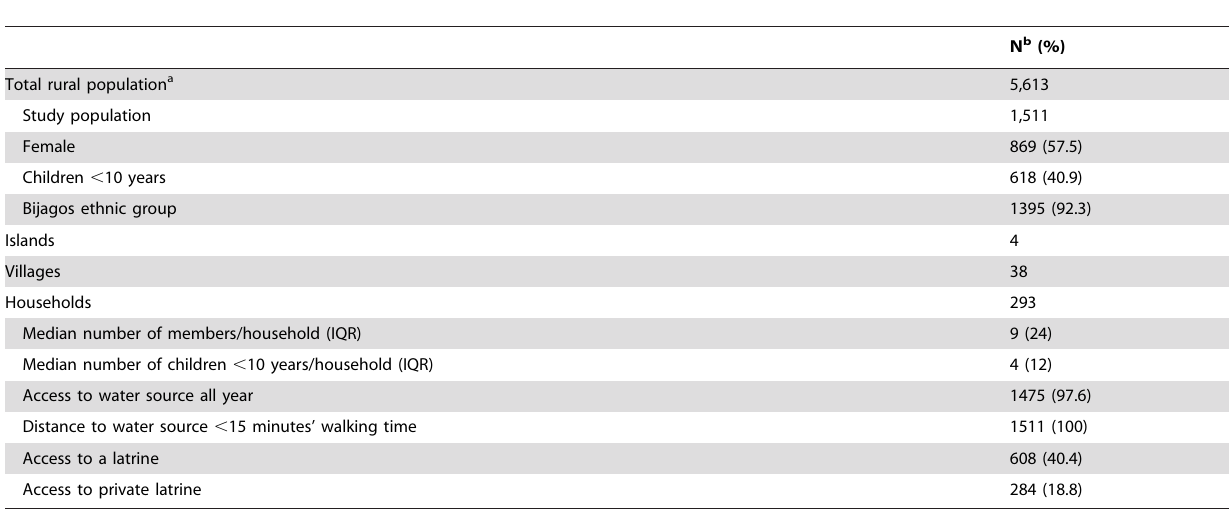
Table 1. Study population characteristics.